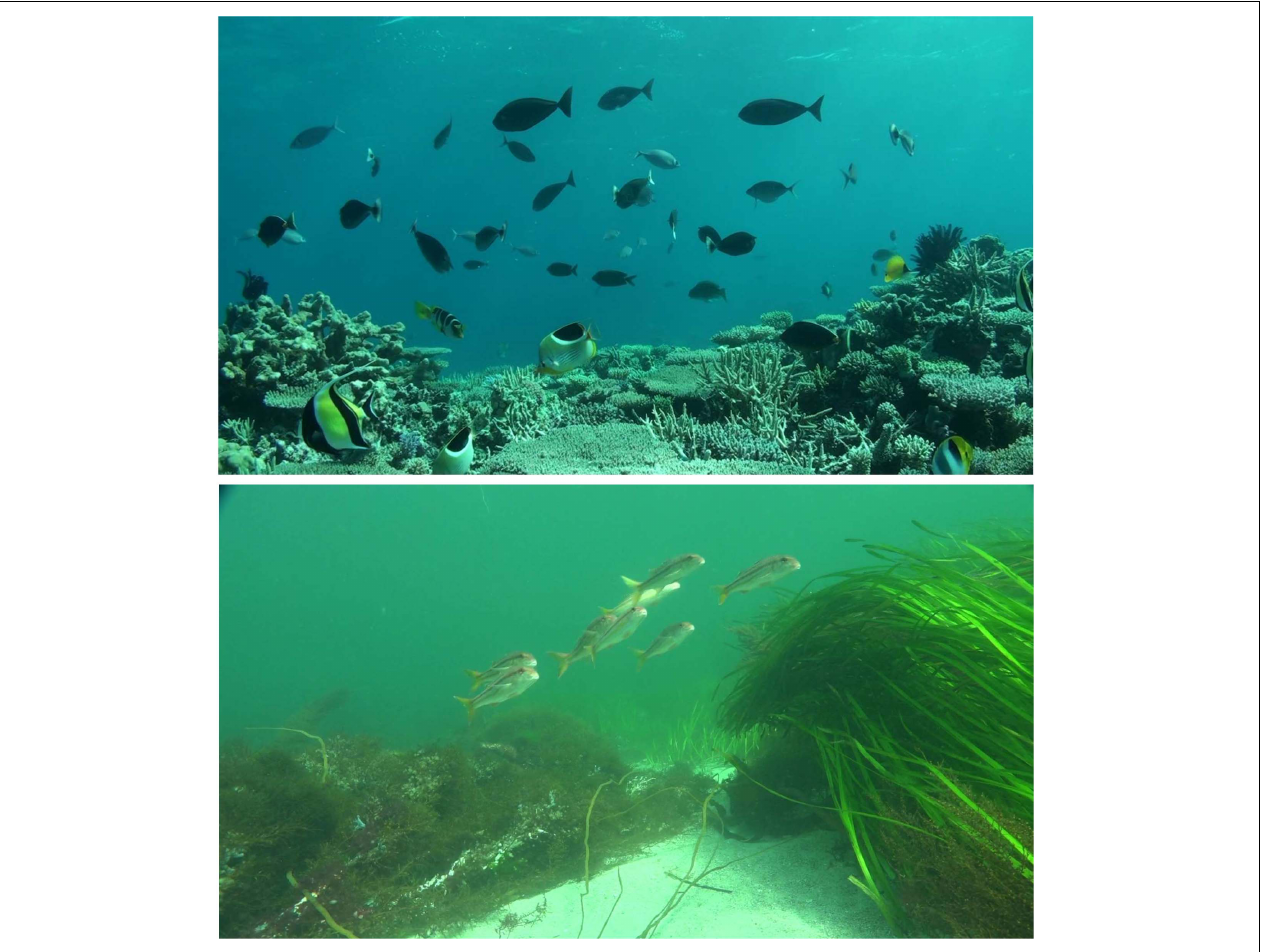
FIGURE 6 | Example of images recorded by the STAVIRO. Top: Chesterfield reef, CSMP, New Caledonia. Bottom: Concarneau Bay, Atlantic